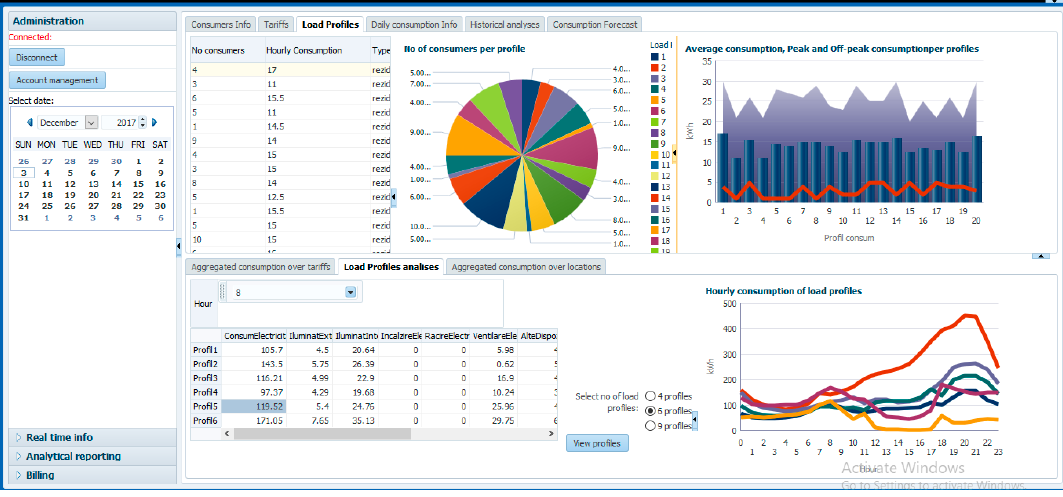
Figure 18. Consumption profiles